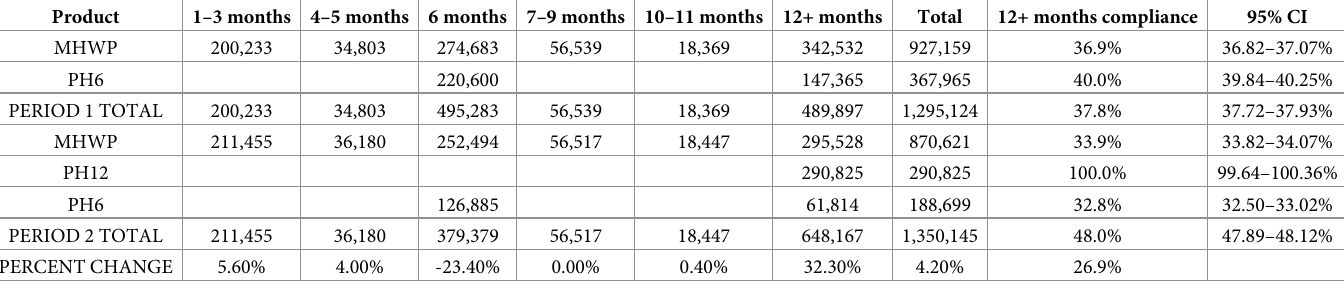
Table 6. Patient level comparison of doses purchased Period 1 vs Period 2. PH 6 to PH 12 Users.